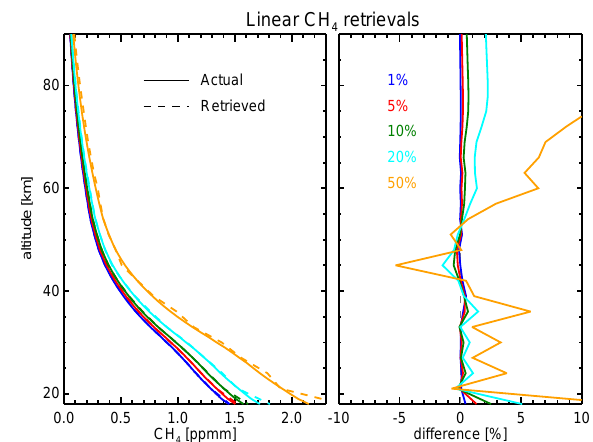
Fig. 5. Linearly retrieved CH 4 for different increments of the entire CH 4 profile (left) and percentage difference between the actual and retrieved values (right).